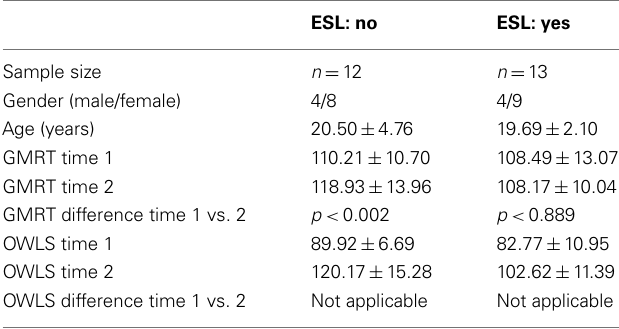
Table 2 | Demographic characteristics and standardized literacy measures for the training group as a function of speaking English as a second language (ESL).